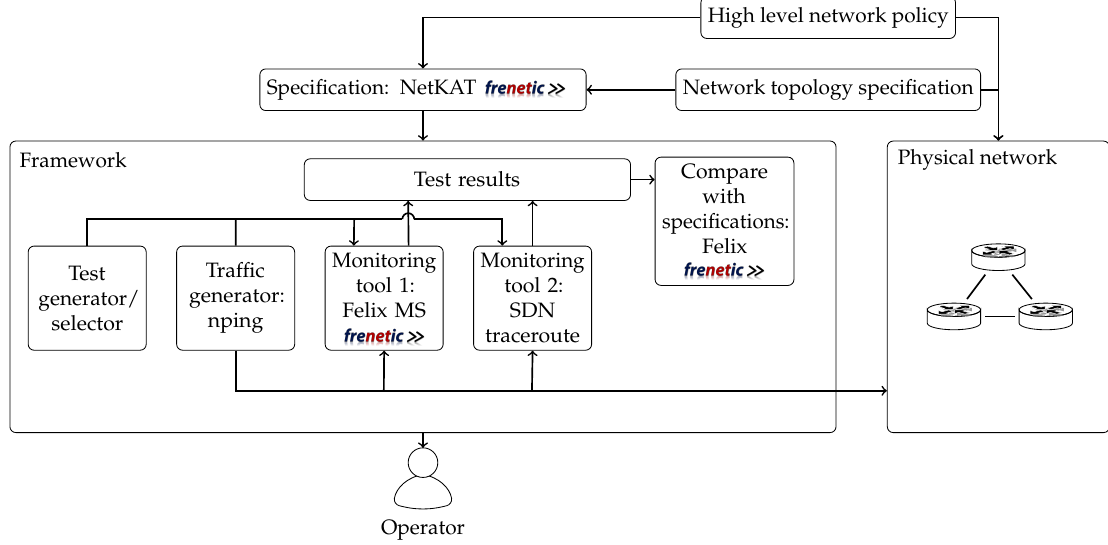
Figure 2. High-level concept of our